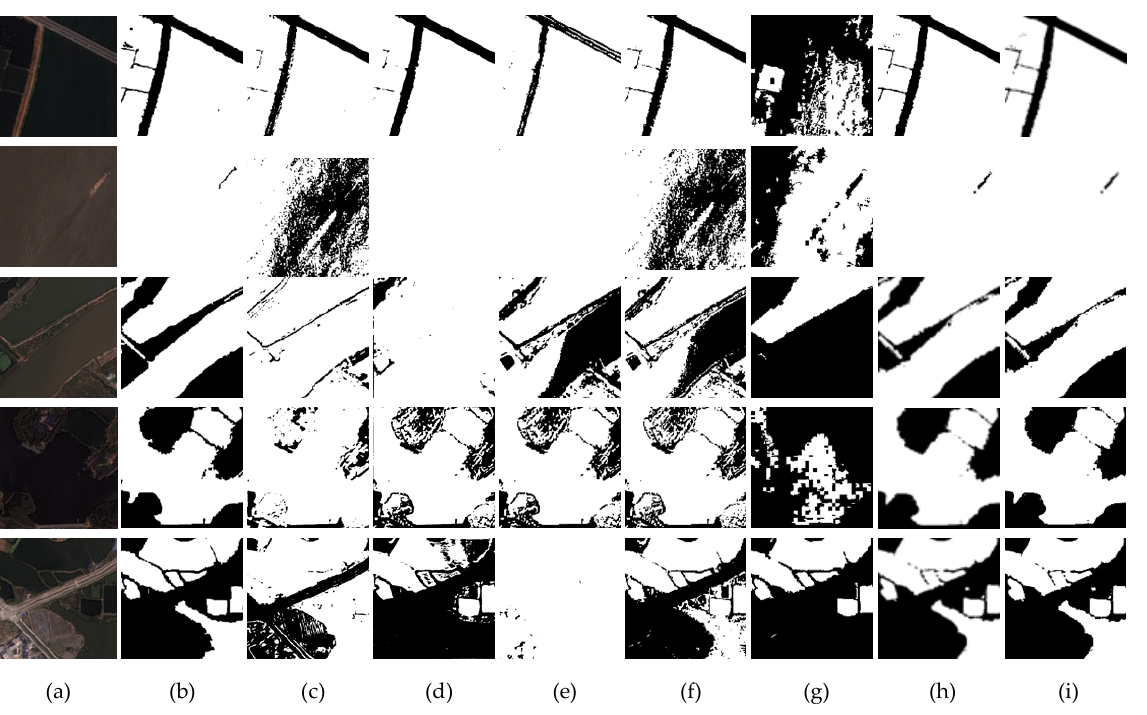
Figure 6. Qualitative comparisons with the other in the target domain. ( a ) Image; ( b ) Ground-truth; ( c ) K-means; ( d ) AC; ( e ) UIS; ( f ) ISODATA; ( g ) ISB; ( h ) SFnet-DA; ( i ) SFnet-DA +